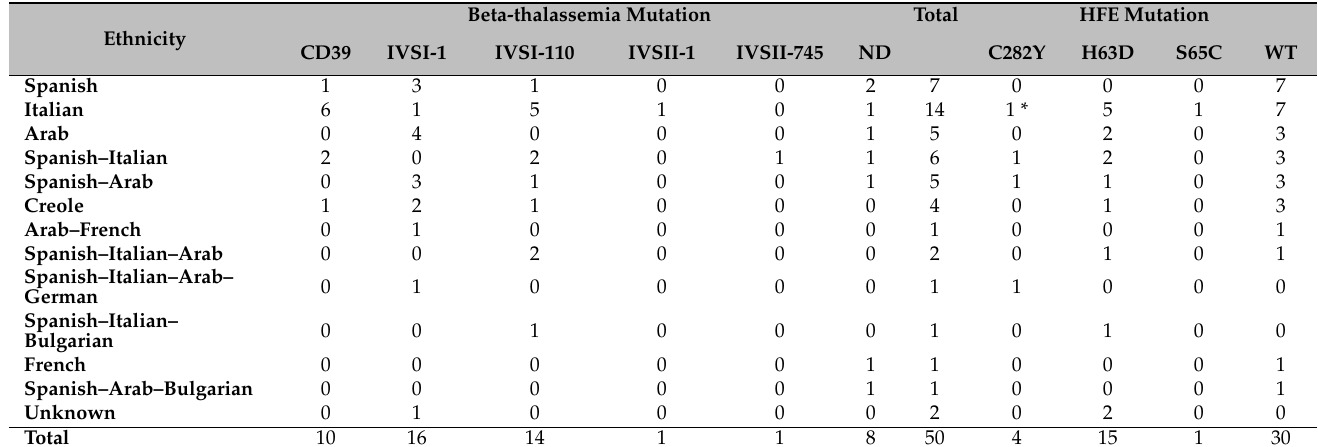
Table 2. Relationship between ethnic origin and mutations detected in heterozygous β -thalassemia subjects.